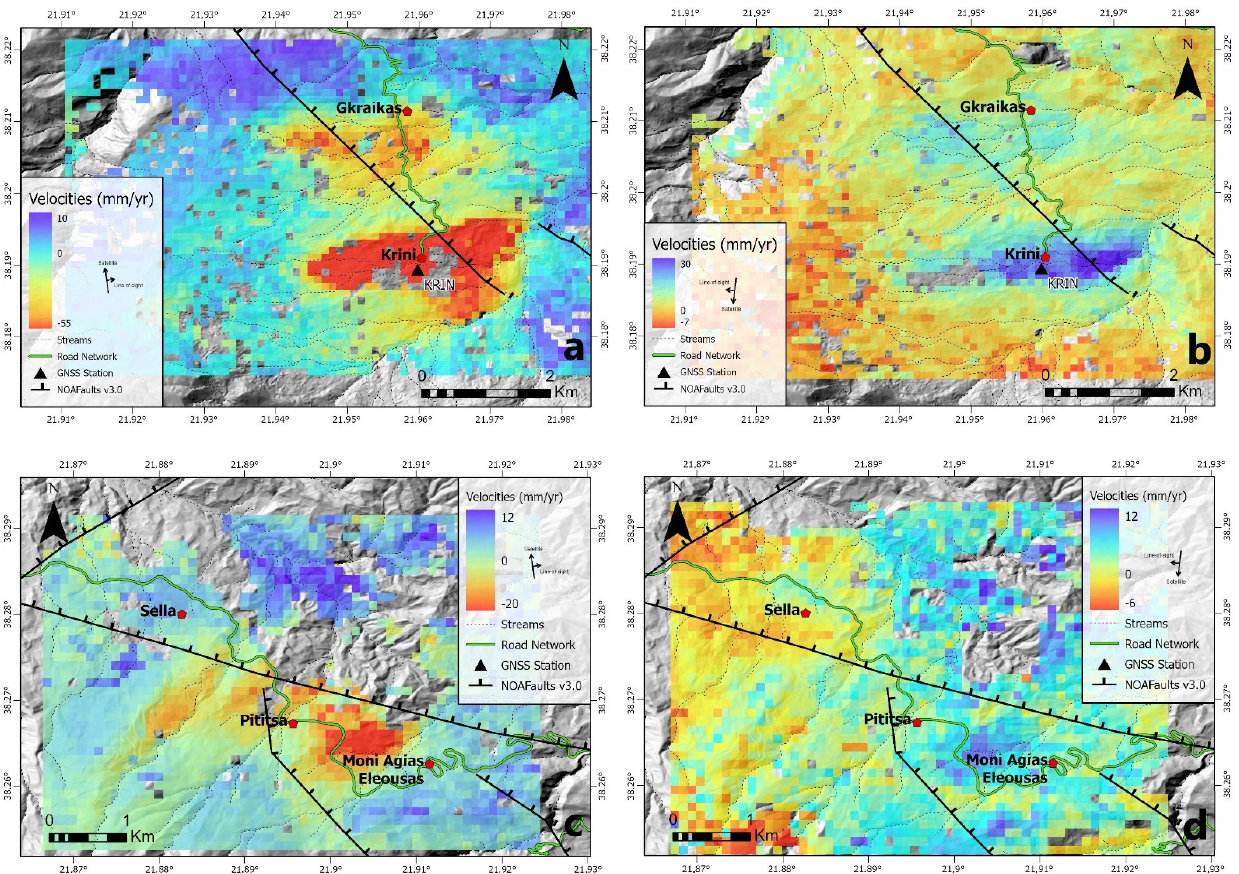
Figure 5. Displacement maps in LOS direction for the broader areas of Krini ( a , b ) and Pititsa villages ( c , d ) for ascending track and descending track ( a ) shows the displacement map for ascending track; and ( b ), for descending track around the village of Krini, respectively. The Figure 5c, d corresponds to displacement map for ascending and descending track around the villages of Pititsa and Sella, respectively.